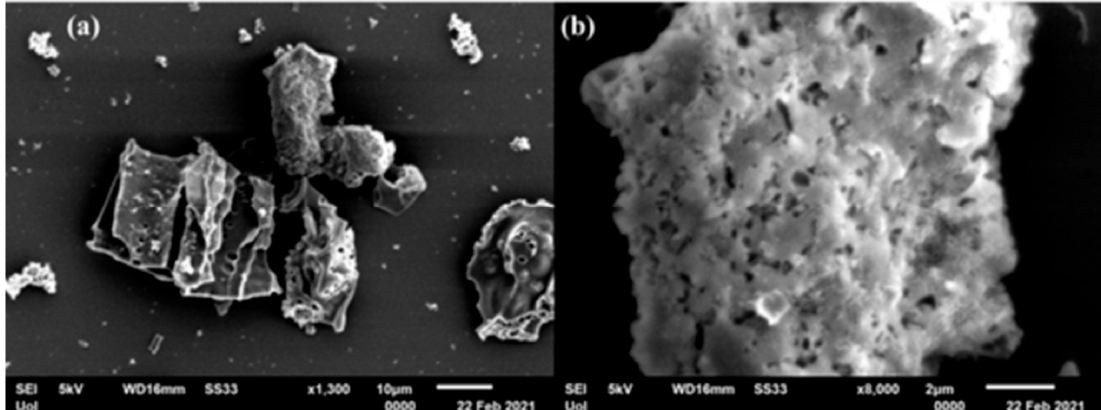
Figure 7. SEM images of the APC sample. ( a ) Magnification ×1300, scale 10 μ m, ( b ) magnification ×8000, scale 2 μ m.